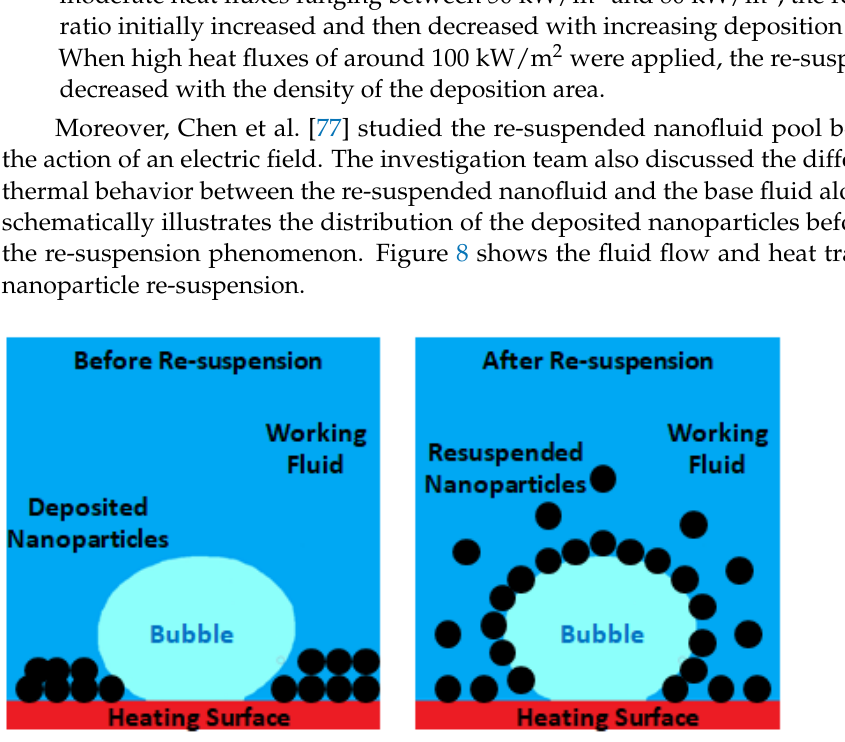
Figure 7. Boiling-induced nanoparticle deposition time-dependent features.